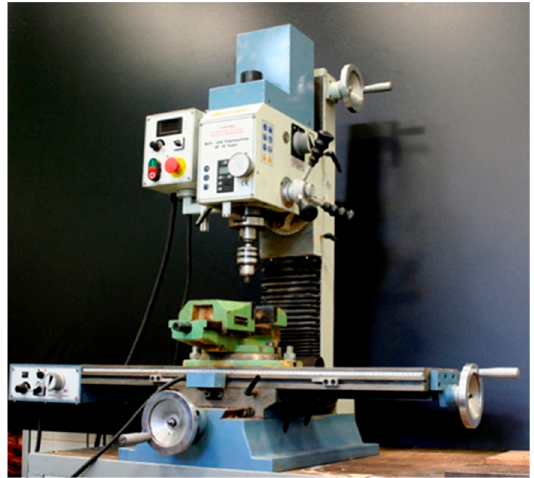
Figure 4. The benchtop drill Bernardo BF 30 used during the highly simplified machinability testing.